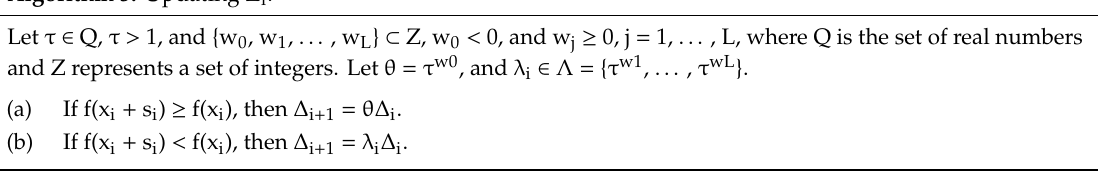
Algorithm 3. Updating ∆ i